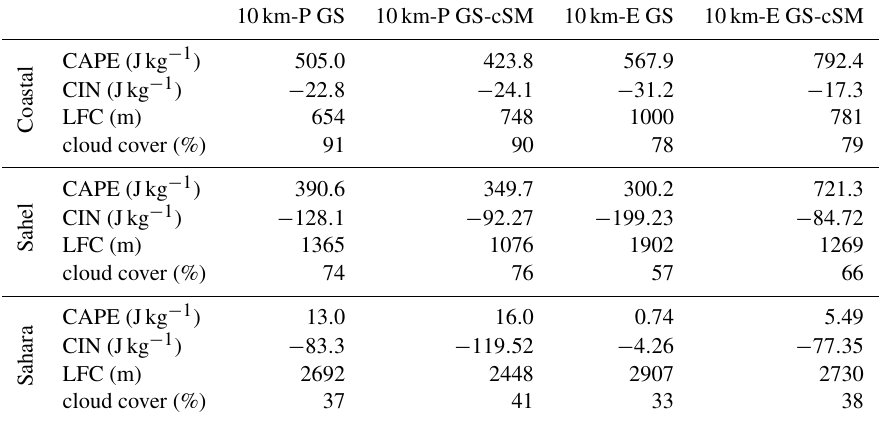
Figure B9. Difference of the JAS mean meridional distributions of latent heat flux (a) , 850hPa temperature (b) , and precipitation (c) between the GS-cSM and the GS simulations (solid lines) as well as for the GS-cSM simulation (dashed lines in panel c ), the 10km-E (blue lines), and the 10km-P (orange lines), respectively. The vertical black dashed lines indicate the boarders of the coastal, the Sahel, and the Sahara region outlined in Fig. 1. Table B2. 12:00UTC JAS mean values of CAPE, CIN and JAS mean values of the level of free convection (LFC), and total cloud cover for the coastal, Sahel, and Sahara region (Fig. 1) as well as for the 10km-P DS, GS, and GS-cSM simulation and for the 10km-E DS, GS, and GS-cSM